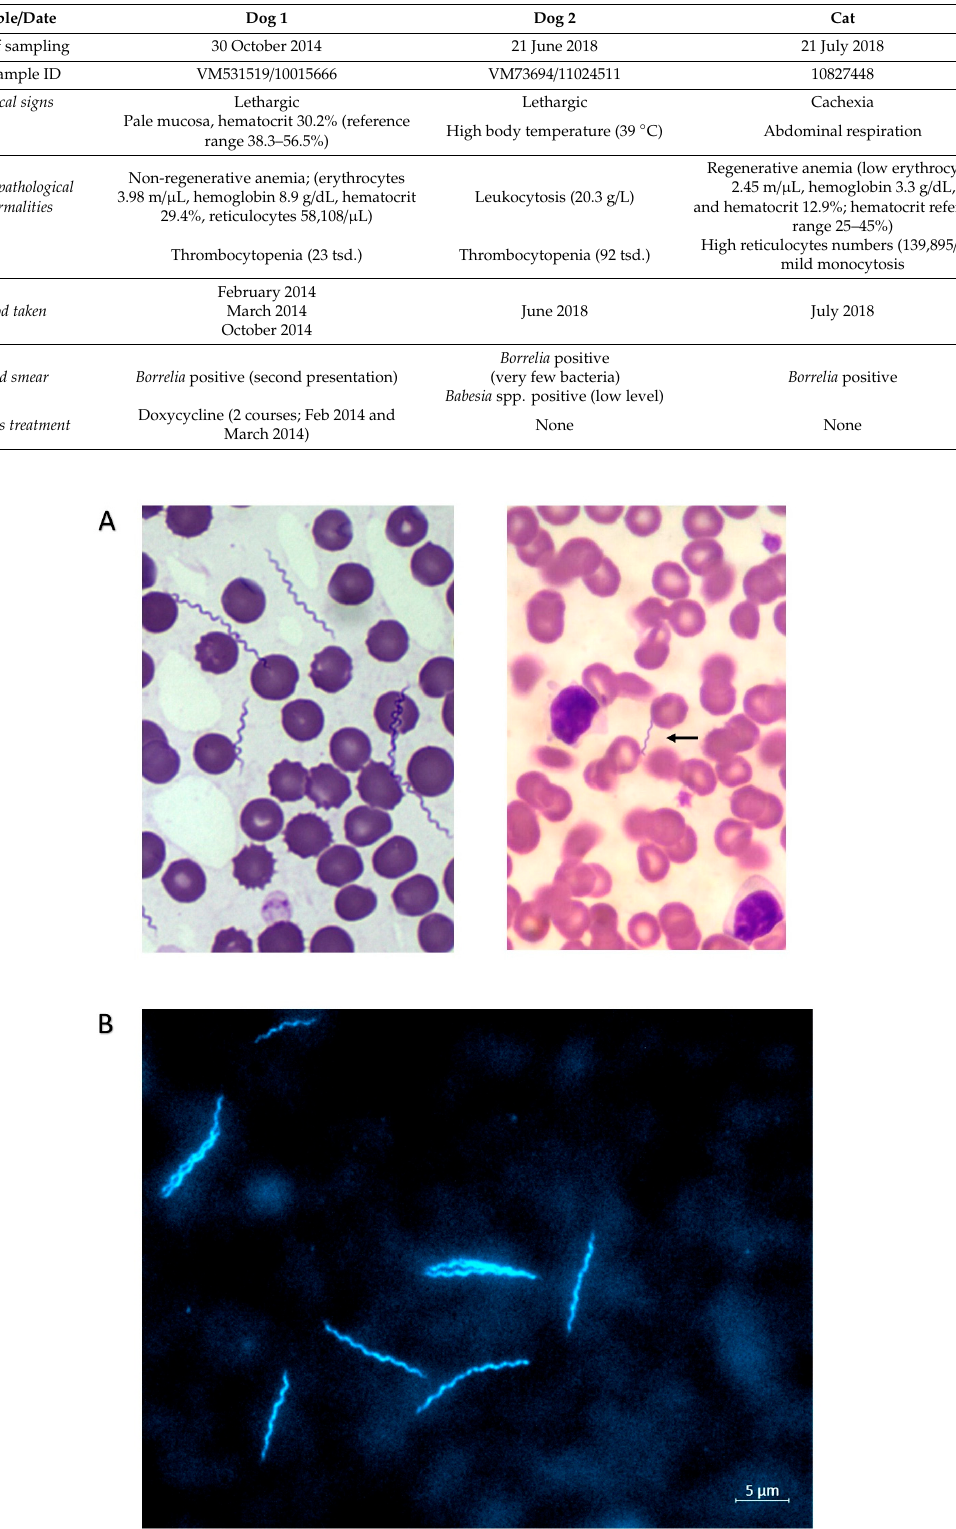
Figure 1. Spirochetes in Giemsa-stained blood smears of dog 1 ( A , left panel, magnification 150x), dog 2 ( A , right panel, magnification 100x, arrow pointing to Borrelia ), and 4 ′ ,6-diamidino-2-phenylindole (DAPI) stained Borrelia from an in vitro culture of infected cat blood ( B ).